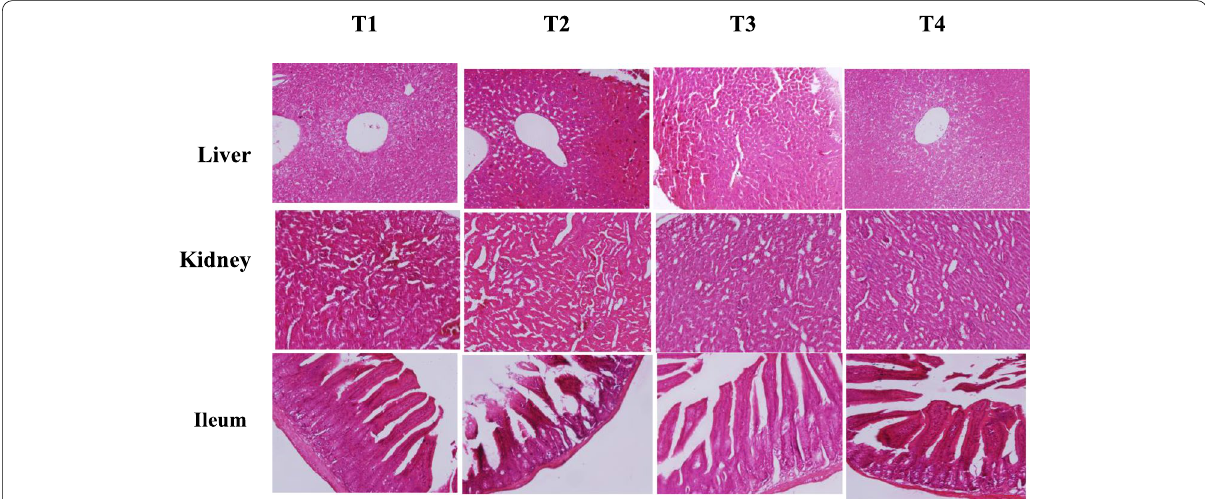
Fig. 2 Histopathological analysis of the liver, kidney, and ileum of the mice under different treatment conditions. T1: normal diet. T2: normal diet infection by E. coli (O157: H7) on day 21. T3: a normal diet enriched by a nonencapsulated phenolic-rich fraction (10 mg TPC/kg BW/ + day) infection by E. coli (O157: H7) on day 21. T4: a normal diet enriched by a nanoliposome-encapsulated phenolic-rich fraction (10 mg TPC/kg + BW/day) infection by E. coli (O157: H7) on day +